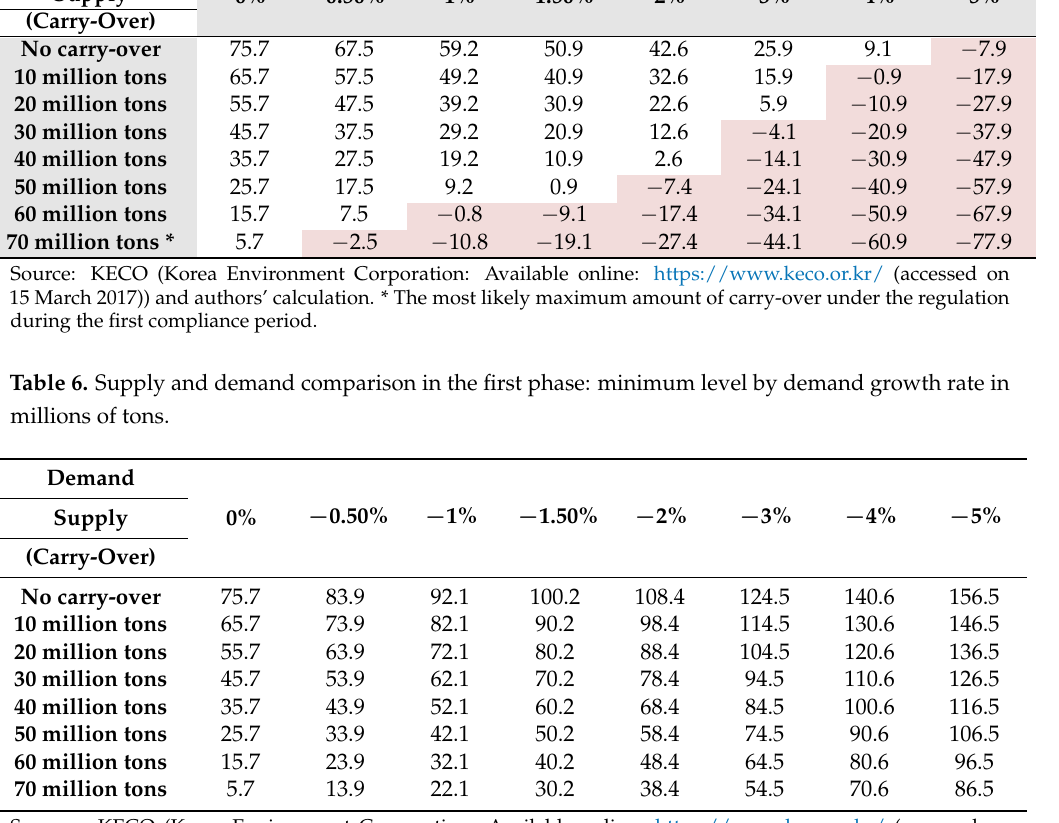
Table 5. Supply and demand comparison in the first phase: maximum level by demand growth rate, shown in millions of tons. Demand